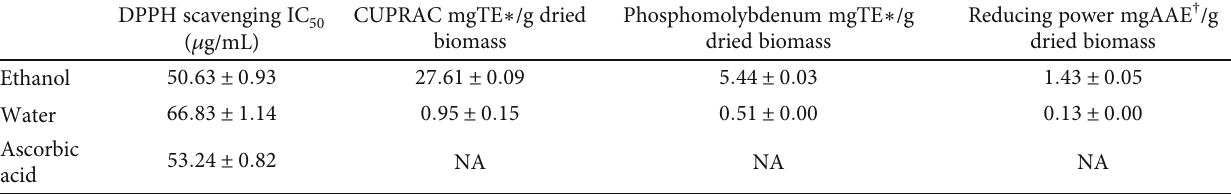
Table 2: Antioxidant activities of P. serratifolia leaf extracts.